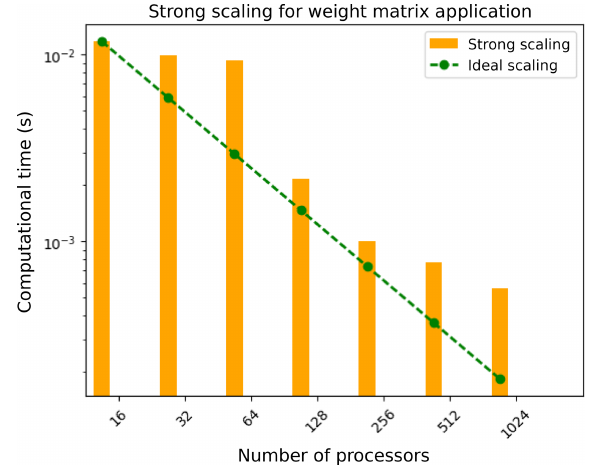
Figure 14. SE → FV remapping weight operator application for the NE120 case on